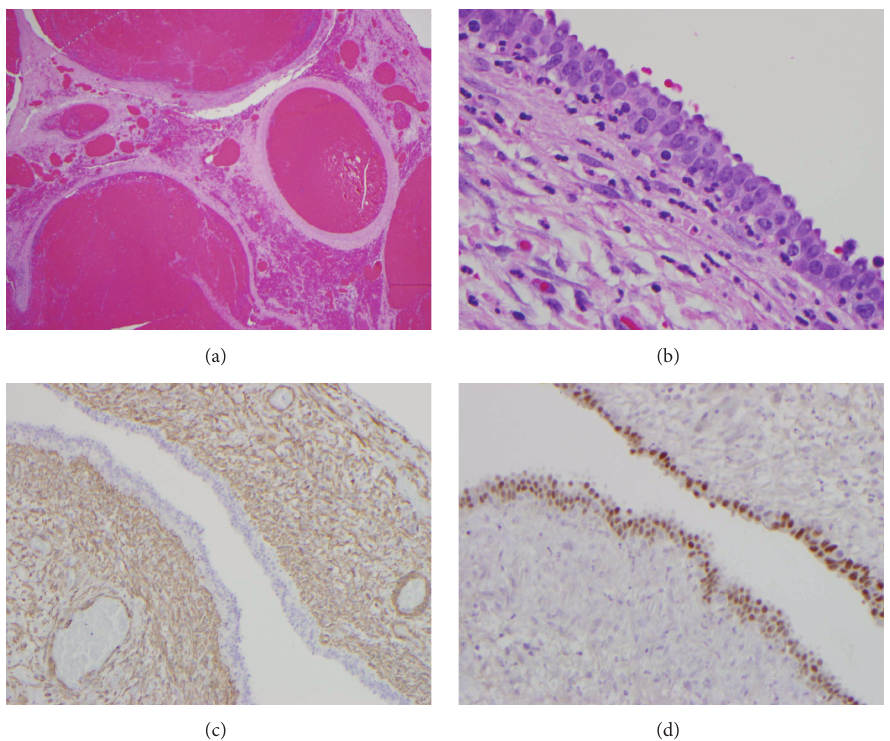
Figure 4: Histopathological images of the resected specimen. Image (a) demonstrates extensive hemorrhagic soft tissue (low power, H&E). Image (b) shows cyst wall lined by cuboidal epithelium (high power, H&E). Image (c) demonstrates smooth muscle in the cyst wall after immunohistochemical staining with smooth muscle actin (medium power, SMA). Image (d) demonstrates positive nuclear immunostaining with PAX-8 (medium power,